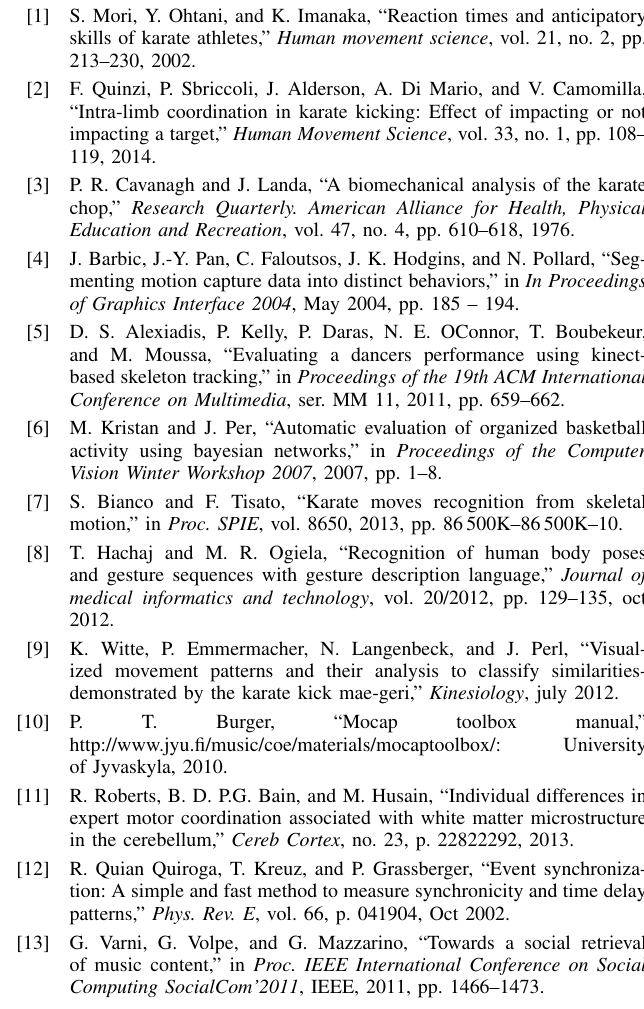
punch/kick movement. The maximum velocity is taken as a separation between the first phase - acceleration and the second phase - deceleration, times t acc and t dec are calculated as the time spend for acceleration and for deceleration,